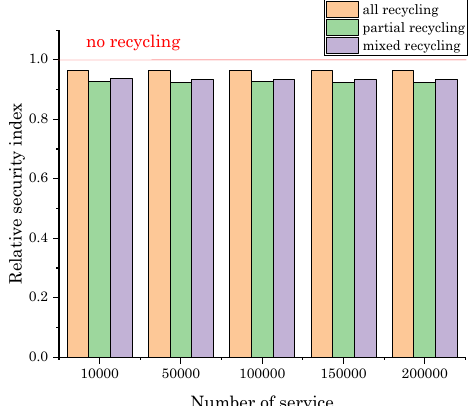
Figure 11. Relative security index of different QKR mechanisms compared to the no-recycling algorithm of traditional QKD networks